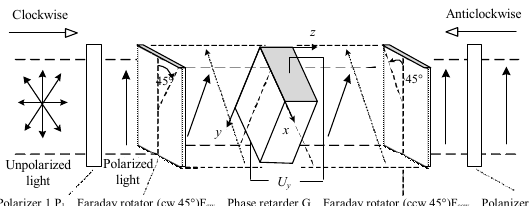
Fig. 2. Structural diagram of spatial nonreciprocal phase